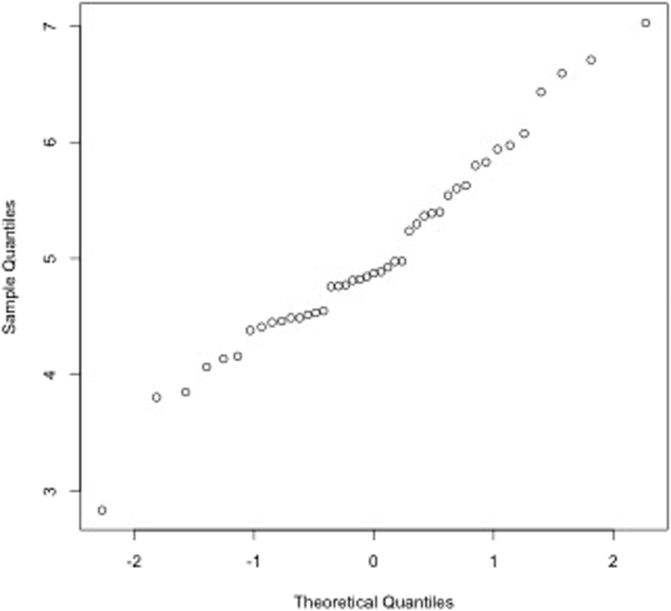
Distribution of plasma cell-free DNA in melanoma patients. The deviations from the straight line of the Q–Q plot are minimal, confirming the likelihood of a normal distribution.